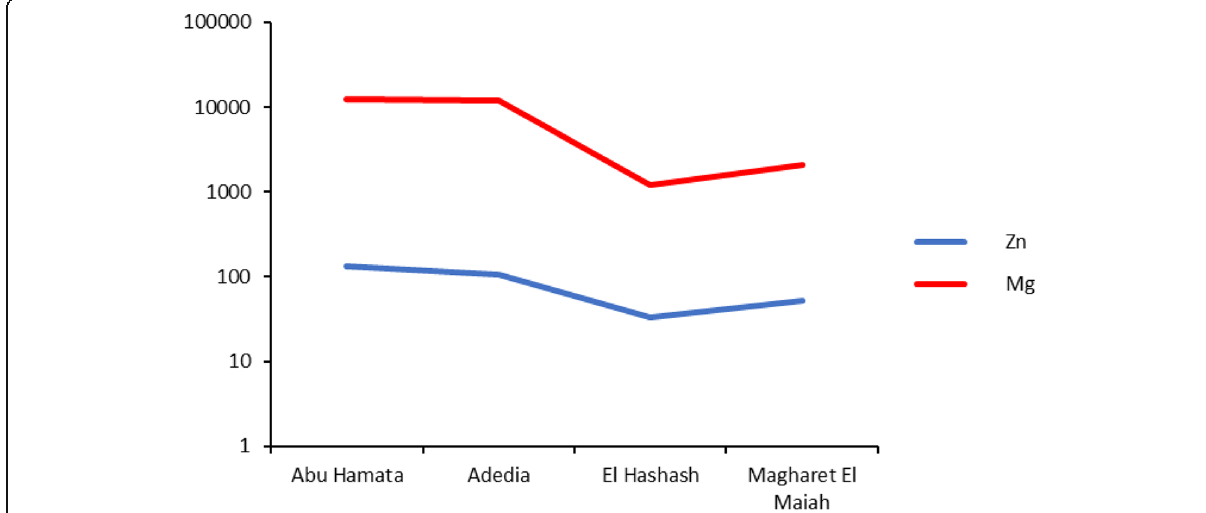
Fig. 12 Correlation between zinc and magnesium in the studied Paleozoic mudrocks